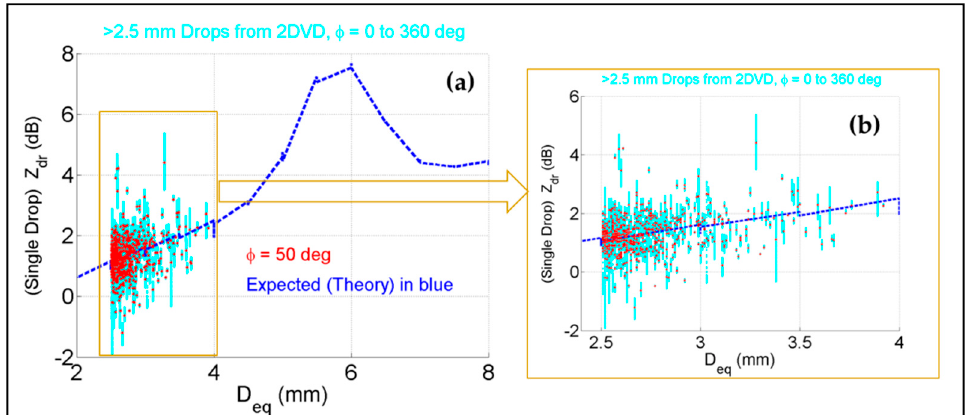
Figure 5. ( a ) Single drop Z dr versus D eq for the reconstructed drops for all φ angles in cyan and for φ = 50° in red, together with those for the Beard–Chuang (BC) model (dashed line in blue) using T ‐ matrix; ( b ) same as panel ( a ) but zoomed in to cover the brown dotted line box.